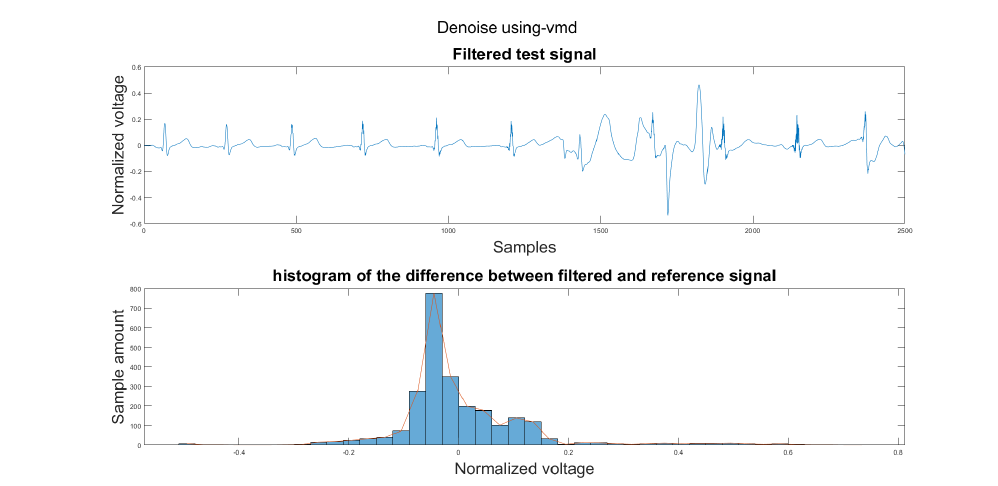
Figure A27. (1) Test signal, (2) histogram of the difference.